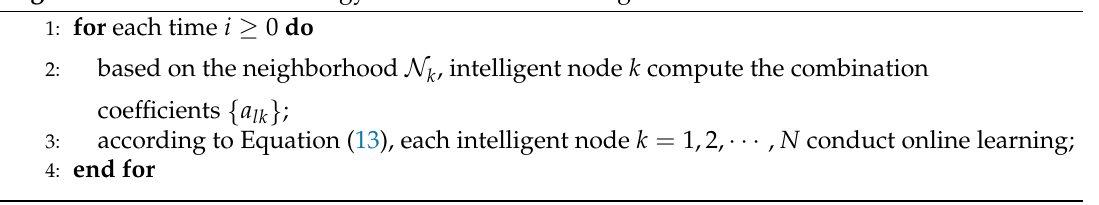
Algorithm 2: Consensus strategy for distributed learning.